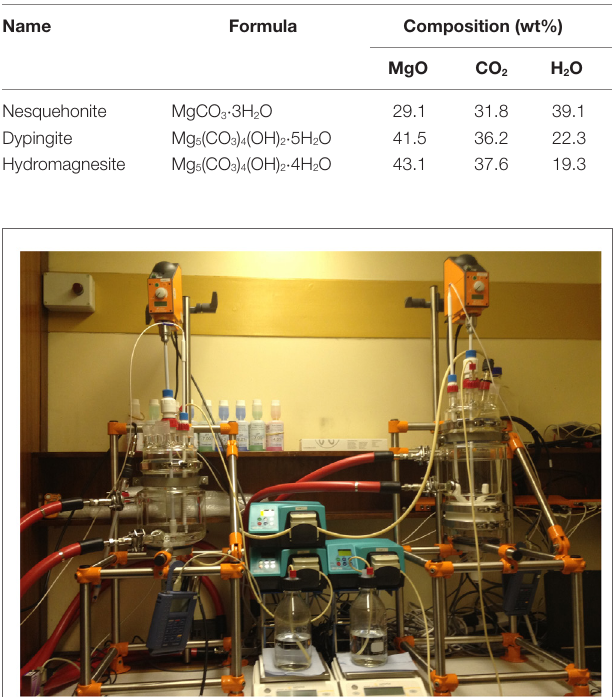
FigUre 1 | Photo of the lab-scale reactor used for the synthesis of Mhch phases (the total height is about 1.3 m and the two double- walled reactors have a 2-l internal capacity)